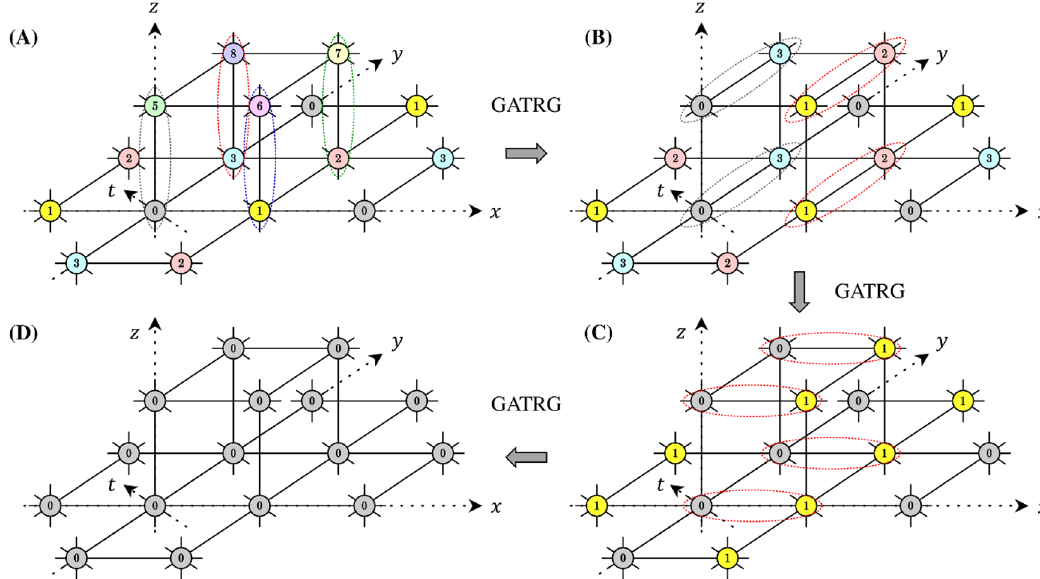
Figure 2 . Schematic illustration of the coarse-graining with the GATRG. Coordinate axes in Λ are shown as dotted lines with arrows. Different numbers are assigned to specify different tensors. (A) Initial tensor network in eq. (2.9). Eight types of tensor are located at a spatial unit cube. A periodic structure is explicitly shown on x - y plane. The tensor network is uniform in t -direction. (B) The first coarse-graining along z -direction reduces types of tensor from eight to four. The tensor network becomes uniform in t -, z -directions. (C) The second coarse-graining along y -direction makes the structure uniform except in x -direction. (D) Totally uniform tensor network is obtained by the third coarse-graining along x -direction. In the following coarse-graining steps, the structure is